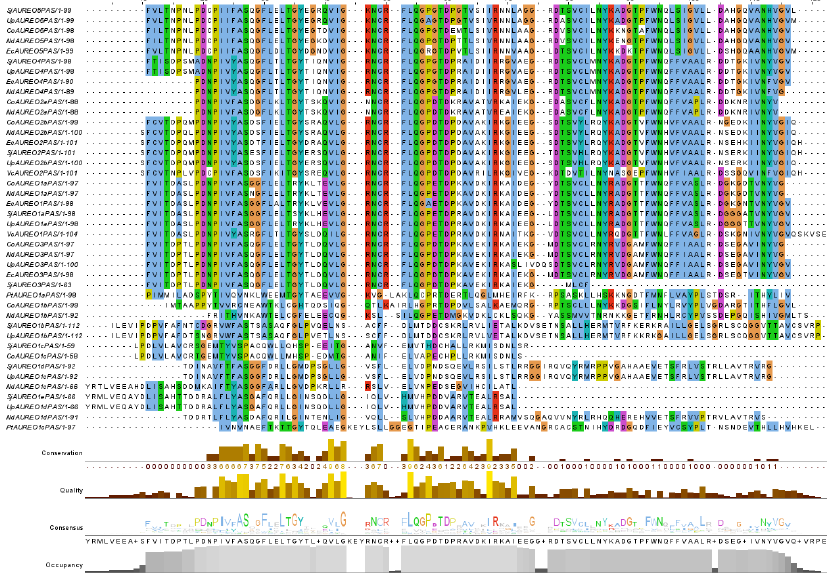
Scheme 1. Characteristics of each repeat of AUREO. Comparison of the bZIP ( Top ) and LOV ( Bottom ) domains of AUREO proteins from S. japonica and other six algae. i.b. Figure 1B. Blue: Hydro- phobichydrophobic amino acid; Red: Positive charge hydrophobic amino acid; Magenta: Negative charge hydrophobic amino acid; Green: Polarhydrophobic amino acid; Yellow: Prolineshydropho- bic amino acid; Orange: Glycineshydrophobic amino acid; White: Unconserved. To gain insight into the gene structure of the AUREO genes from Phaeophyta, their exon/intron organization was analyzed (Figure 2). The number of exons within the AU- REO gene tegument of the three brown algae ranged from three to ten, with an average of seven. The largest number of exon structures were Sj AUREO1a and Up AUREO1a with 10 exons, while the smallest was UpAUREO2 with only 3 exon junctions. Despite inter- specific differences, the structure of the intron exons of the three brown algals ( E. silicu- losus , S. japonica , U. pinnatifida ) AUREO genes differed somewhat more markedly between subgroups than between species within the same subgroup of AUREO.